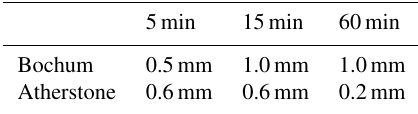
Table 2. Censor selection for model